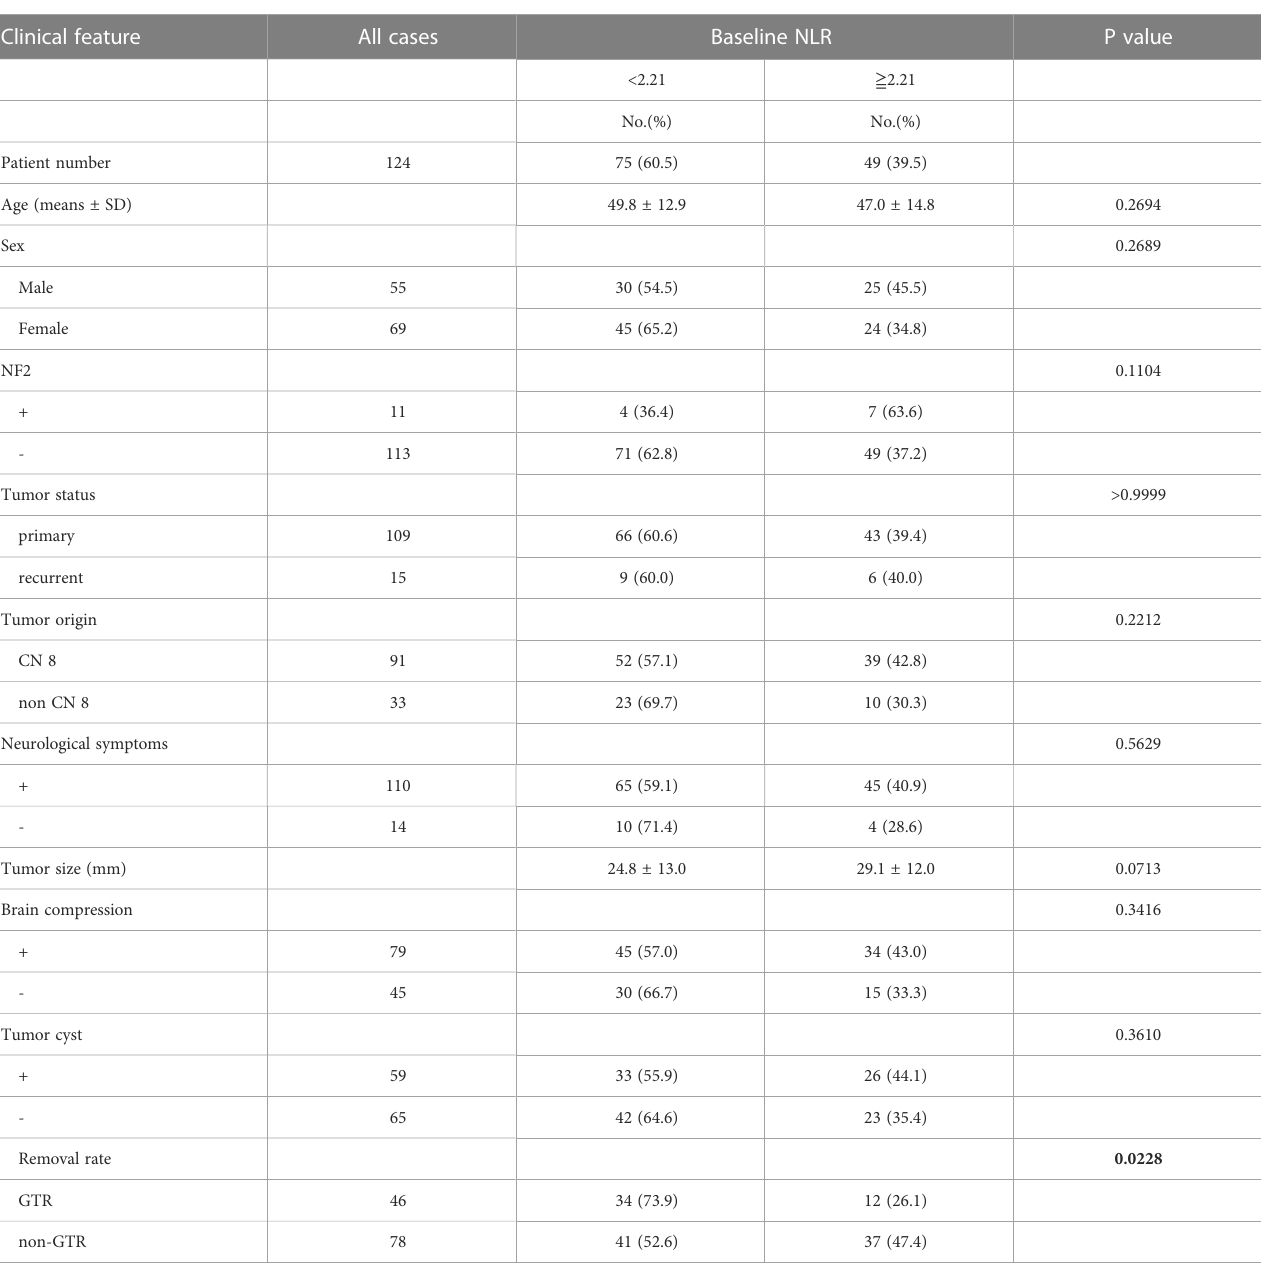
TABLE 1 Patient and tumor characteristics. Clinical